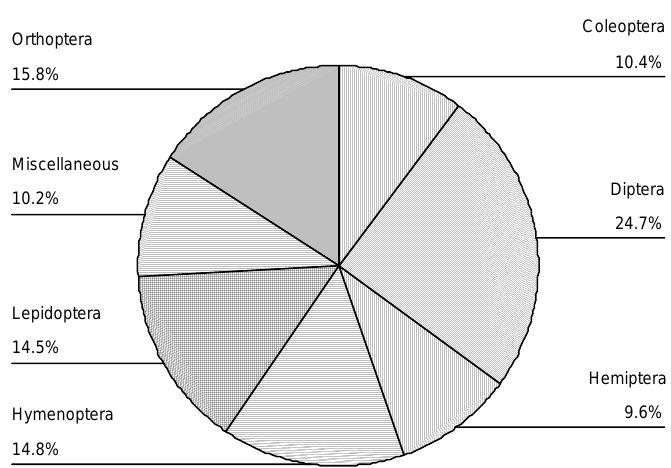
FIGURE 6. Overall composition of insect community.